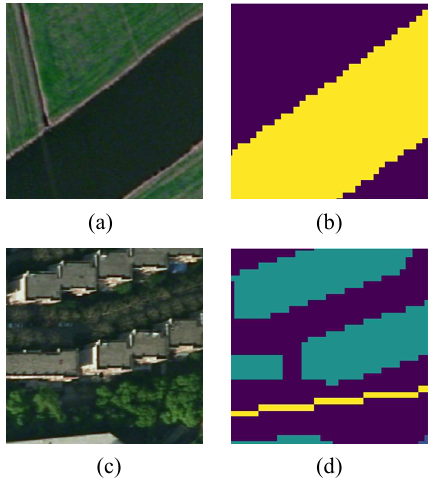
Figure 1. Original maps (a) and (c), and corresponding label maps (b) and